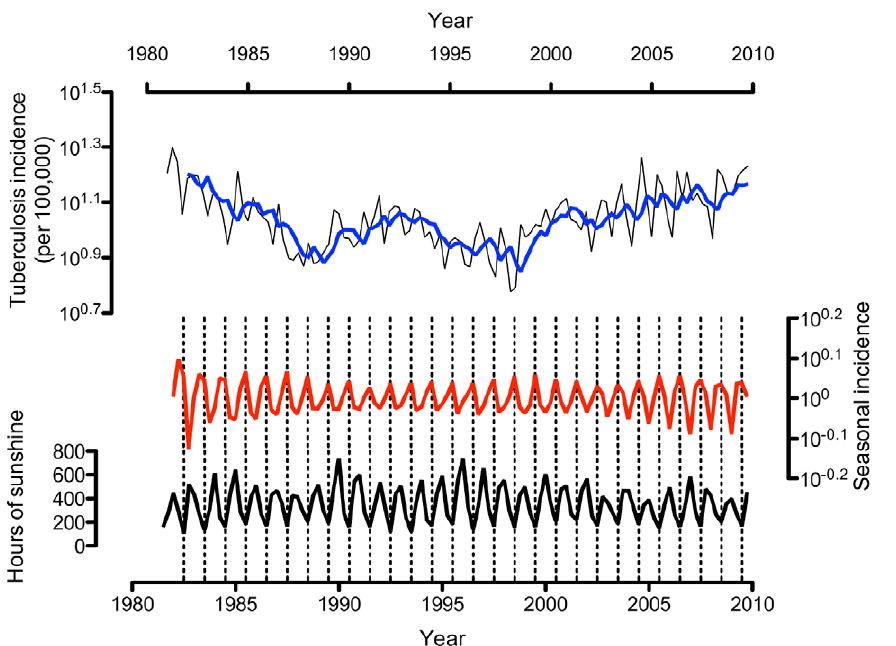
Figure 1. Total hours of sunshine and tuberculosis notifications. Note.– The thin black line above is the tuberculosis incidence per season. The tuberculosis incidence has been decomposed into a trend component (the thick blue line above) and a stochastic seasonal component (the thick red line across the middle of the graph). The thick black line below is the total hours of sunshine per season shifted two seasons (six months) to the right. Thin vertical interrupted lines mark the winter troughs in hours of sunlight. The graph shows that troughs in the total hours of sunshine per season correlate with peaks in the number of tuberculosis notifications two seasons later.